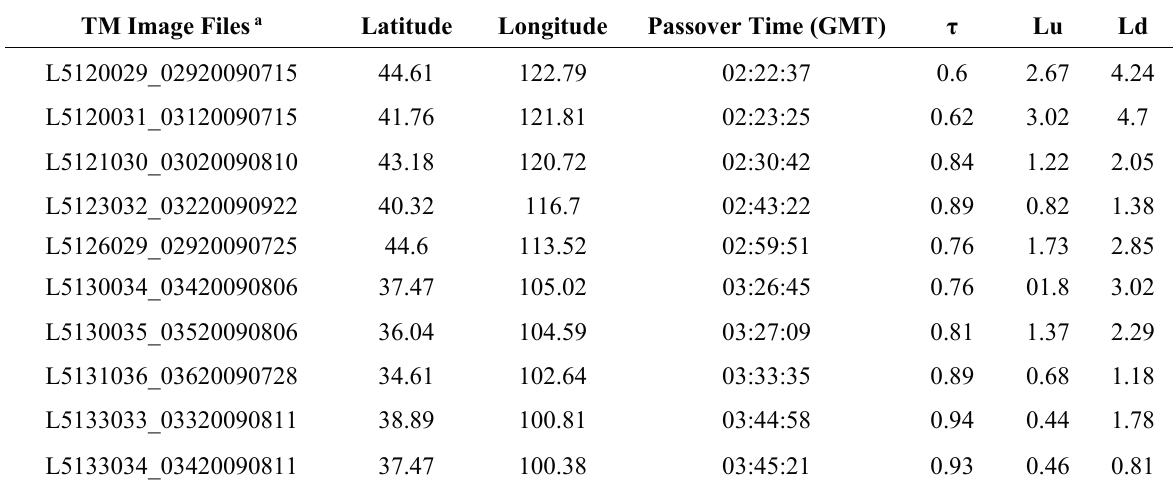
Table 2. Atmospheric parameter